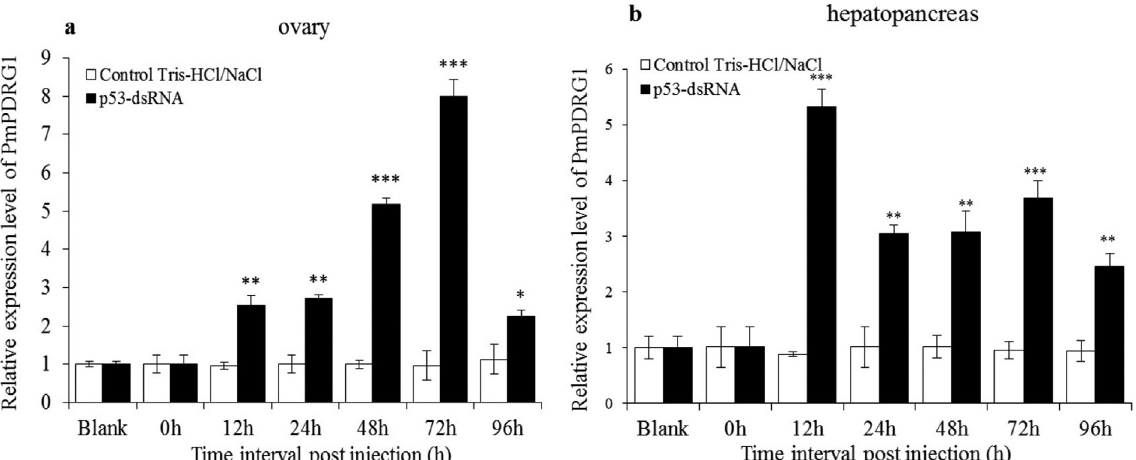
Figure 6 - PmPDRG1 mRNA expression profiles after silencing by Pmp53-dsRNA. (a) PmPDRG1 relative expression levels in ovary tissue post treat- ment with Pmp53-dsRNA; (b) PmPDRG1 relative expression levels in hepatopancreas tissue post treatment with Pmp53-dsRNA. Vertical bars represent the mean (cid:2) SD (n =3). Significant differences between the experimental and the control group are indicated by asterisks. * P < 0.05; ** P < 0.01; *** P < 0.001).